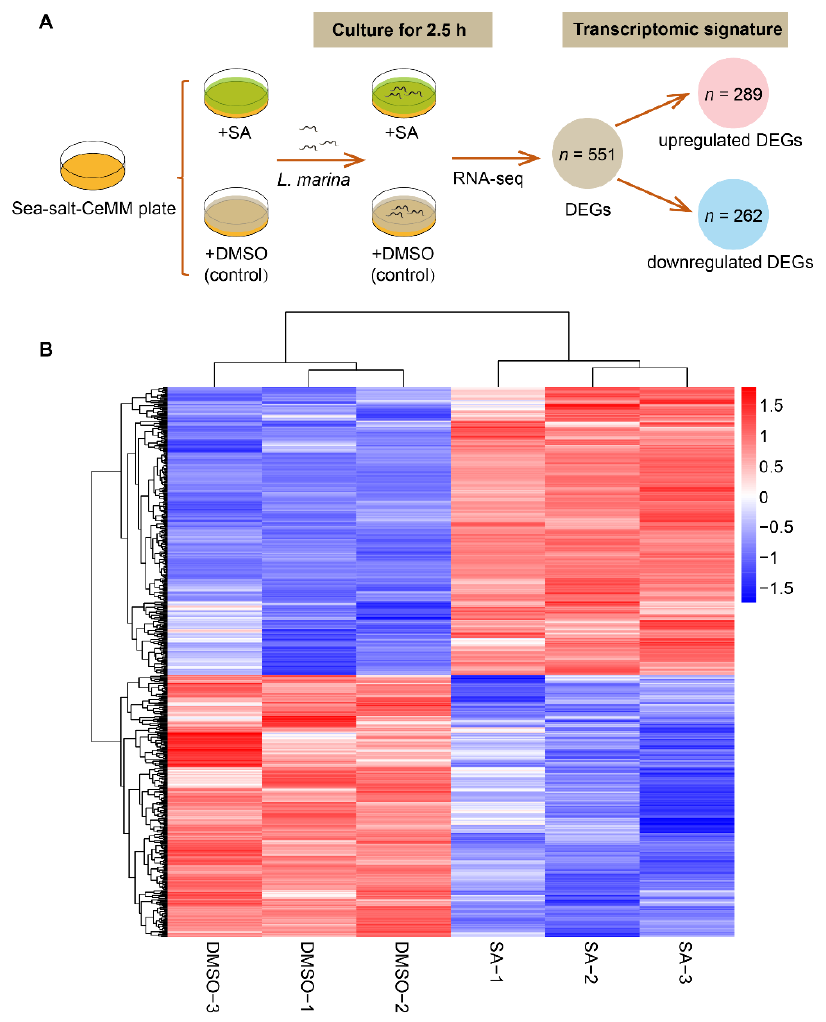
Figure 2. Transcriptome characterization of L. marina supplemented with dietary stearic acid (SA). ( A ) Experimental design and the transcriptomic characterization of dietary stearic acid supplementation. ( B ) Hierarchical clustering of DEGs (differentially expressed genes) in L. marina supplementation with stearic acid and DMSO using the pheatmap package in R. Relative expression levels (z-score, gene expression level based on base-2 log-transformed FPKM value) were indicated for each gene (row) in each sample (column). Red indicates upregulation; blue indicates downregulation. The scale bar shows the z-score for DEGs.